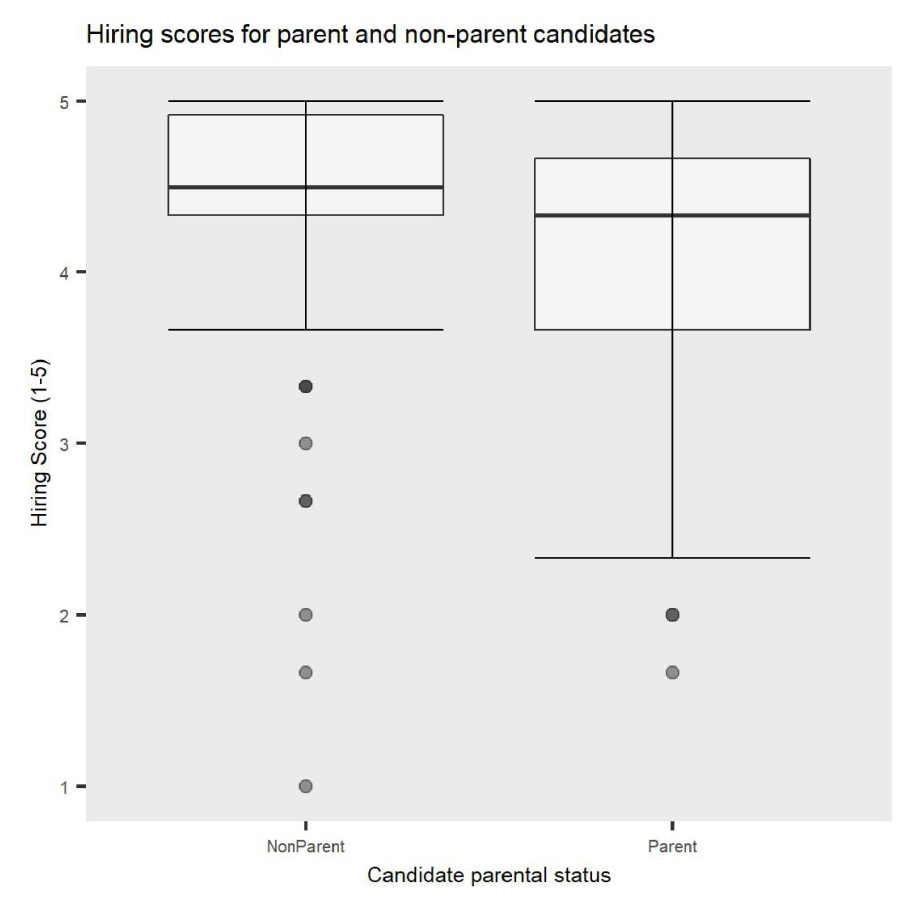
Fig 3. Parent bias. Non-parents received significantly higher hiring scores compared to parents. Error bars represent Standard Deviation